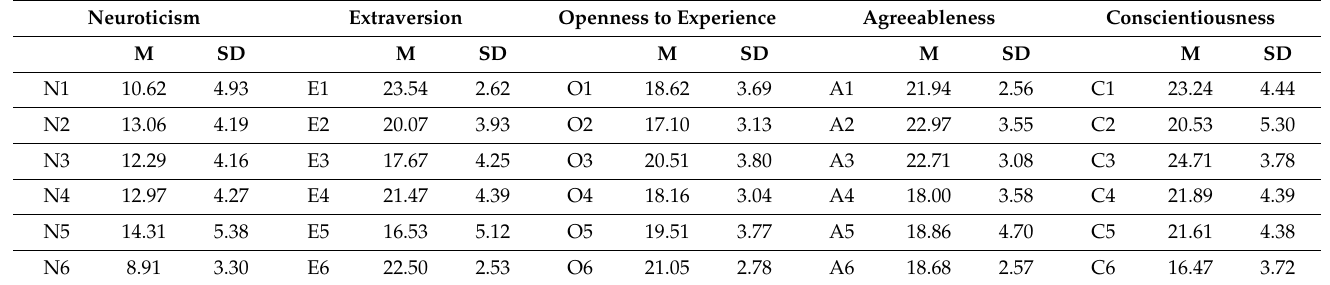
Table 4. The level of traits of individual personality dimensions in the five-factor model in the studied group of sportsmen training team games (N = 213) (descriptive